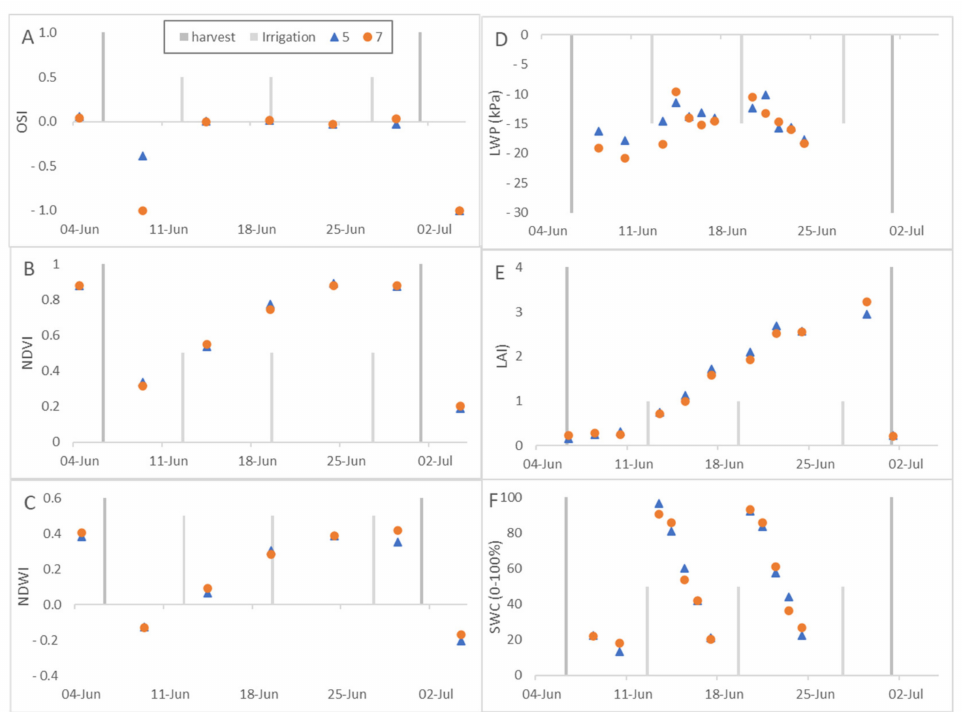
Figure 8. The spectral data ( A – C ) and crop measurements ( D – F ), sites 5 and 7, the fourth growth cycle. Sites 1, 2, 5, and 7, the seventh growth cycle (16 August to 14 September 2021; Figure